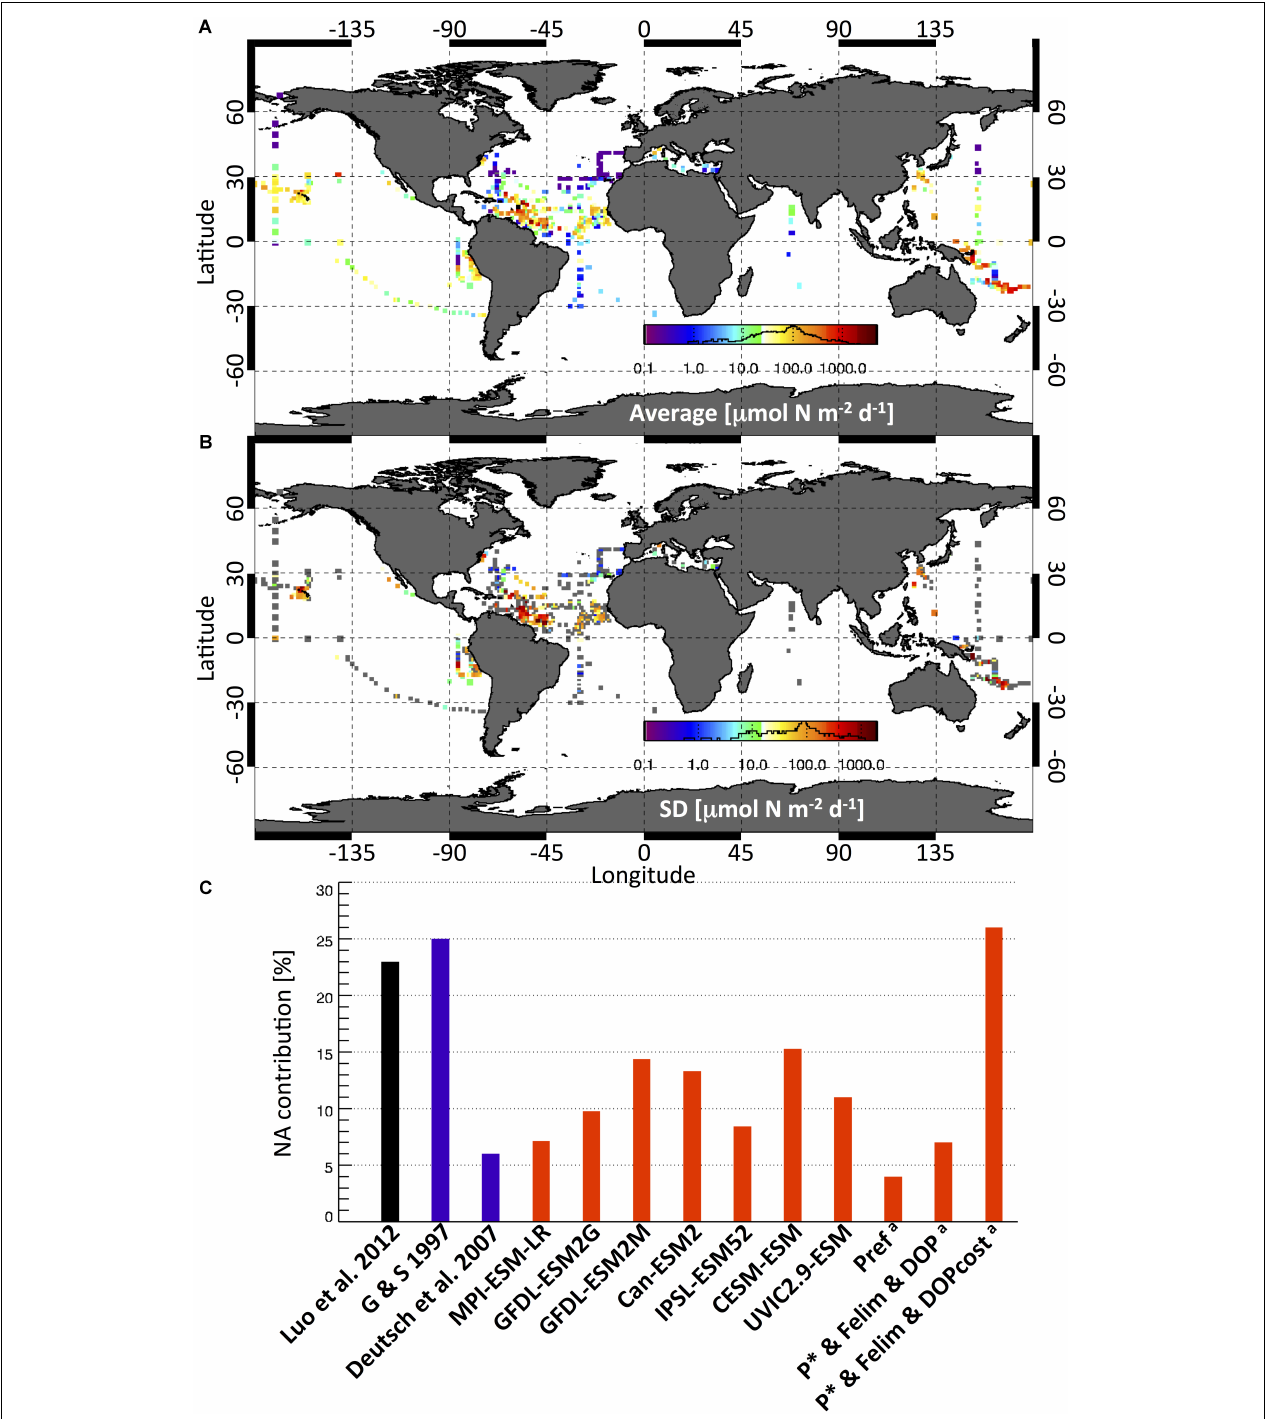
FIGURE 1 | 1 × 1 degree grid (A) average and (B) standard deviation (SD) of depth integrated N 2 fixation rate ( µ mol N m − 2 d − 1 ) experimental measurements from the MAREDAT database (Luo et al., 2012) and 800 additional data points (see text for details). Gray squares in SD plot indicate one-only data point. Data distribution histogram is shown in the color bar. (C) Experimental (black)-, geochemical (blue)-, and model (red) -based estimated contribution (%) of the North Atlantic to global N 2 fixation rates. Models include those of the Coupled Model Intercomparison Project (CMIP5, see Table 1 ), a model with additional energetic costs of DOP uptake (UVIC2.9-ESM, Landolfi et al., 2017) and a model experiments of Landolfi et al. (2015) accounting for preferential phosphorus remineralization (PREF), P ∗ and iron limitation and DOP uptake without (P ∗ and Fe and DOP), and with additional energetic and also N costs (P ∗ and Fe and DOPcost).